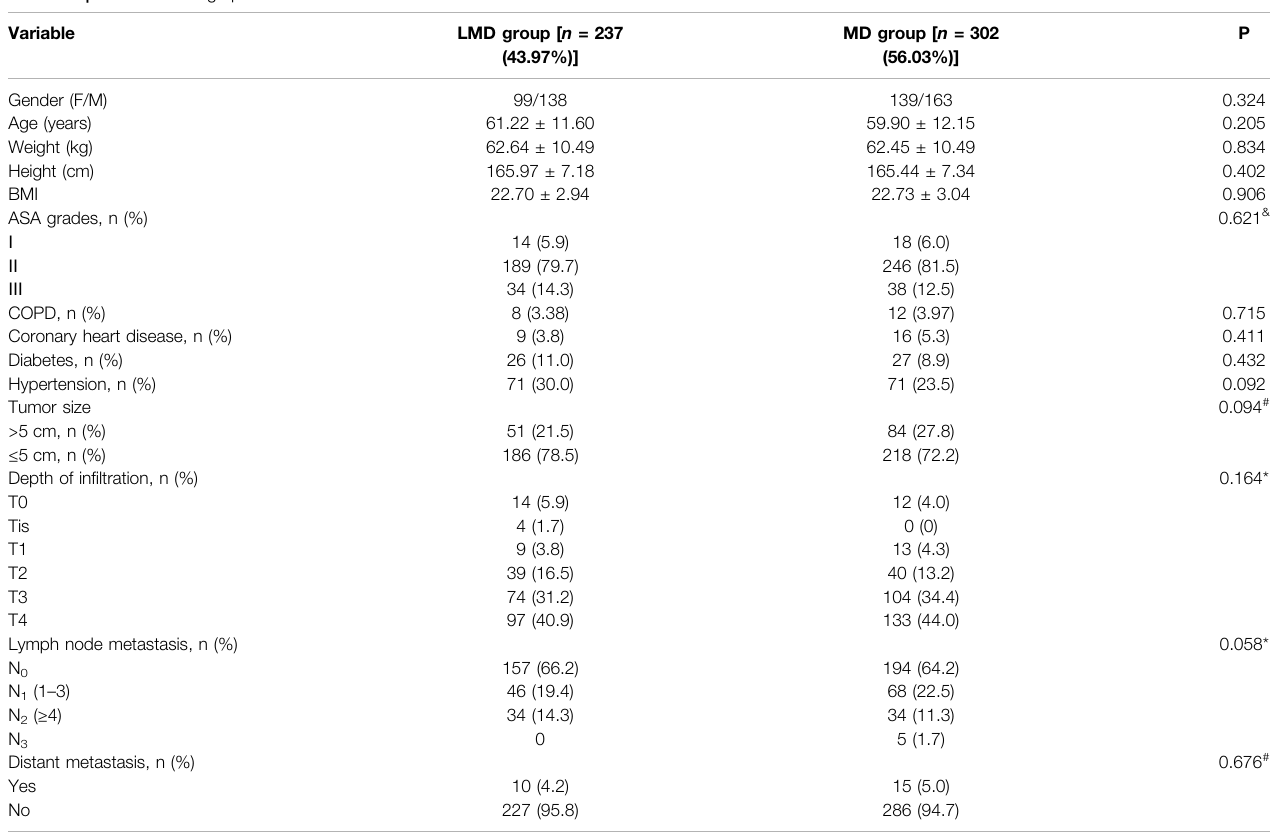
TABLE 1 | General demographic characteristics.